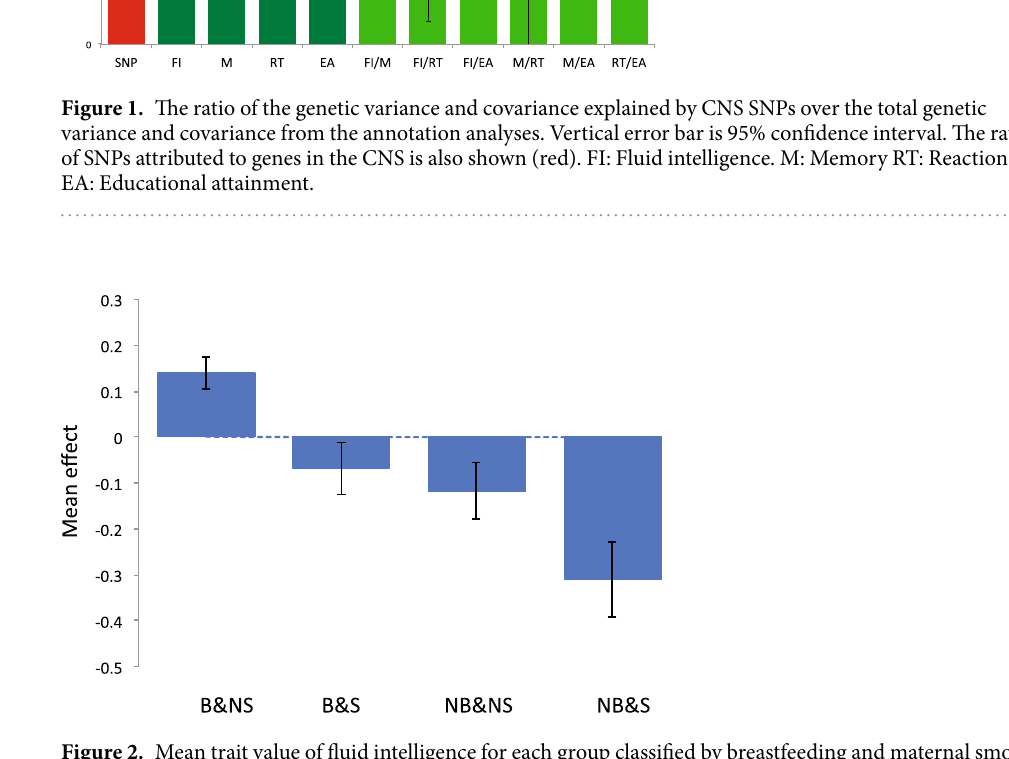
Figure 2. Mean trait value of fluid intelligence for each group classified by breastfeeding and maternal smoking status. Vertical bar is 95% confidence interval. The phenotypes of fluid intelligence were adjusted for birth year, age at recruitment, sex, assessment centre, genotype measurement batch and 15 principal components.